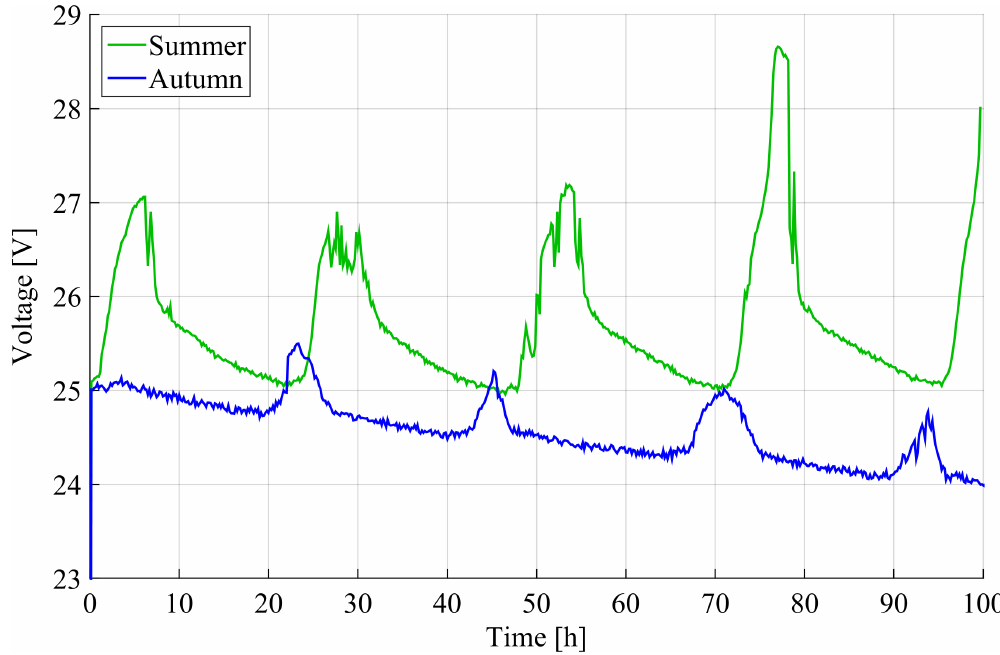
Figure 2. Charging of batteries by the solar panels. The green curve displays the battery voltage during a time-period of four days in the summer. The blue curve is the corresponding measurement during